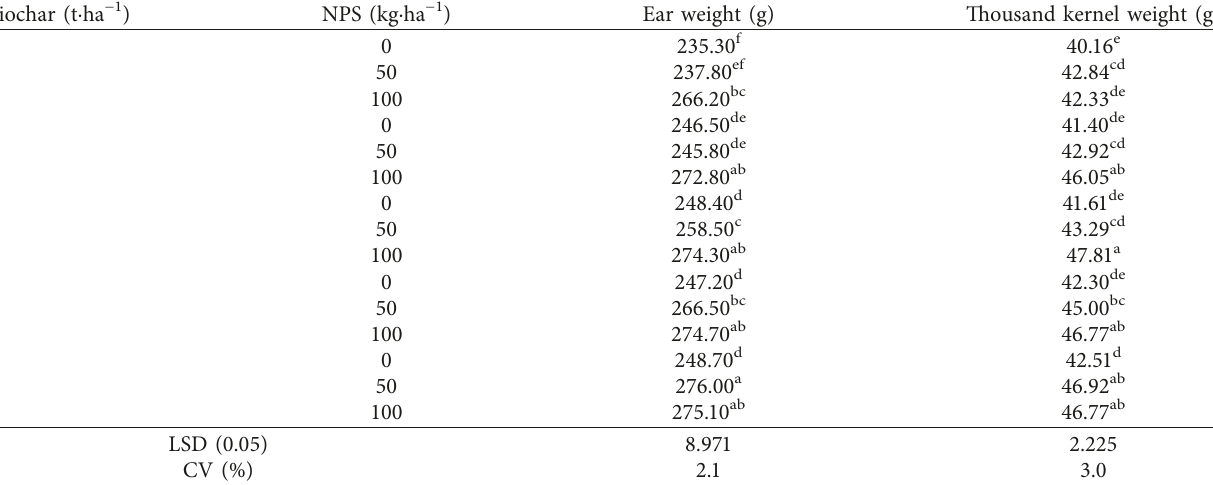
Table 5: Interaction effect of biochar levels and inorganic NPS fertilizer rates on ear weight (g) and thousand kernel weight (g) of maize in Guto Gida, Western